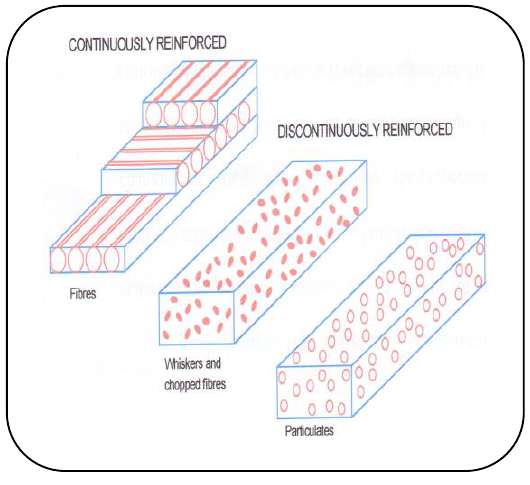
Fig.1: Typical reinforcement geometric for composites